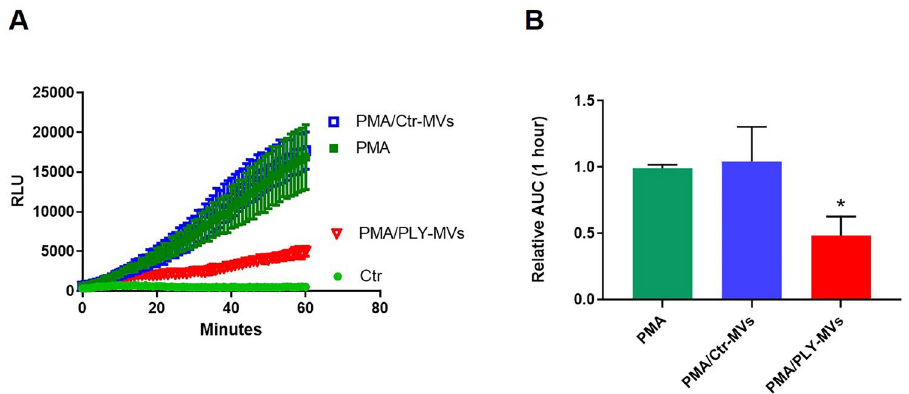
Figure 8. Effect of microvesicles (MVs) on reactive oxygen species (ROS) production from neutrophils. ROS production was measured in neutrophils (PMNs) primed with PMA (0.5 nM) and after stimulation with MVs isolated from control or PLY-treated A549 cells. ROS production was also measured in Ctr and PMA only treated PMNs ( A ) Representative kinetics of ROS production over a period of 1 h. ( B ) Quantification of ROS production. N = 7, *p < 0.001 vs PMA and PMA/Ctr-MVs (One-way